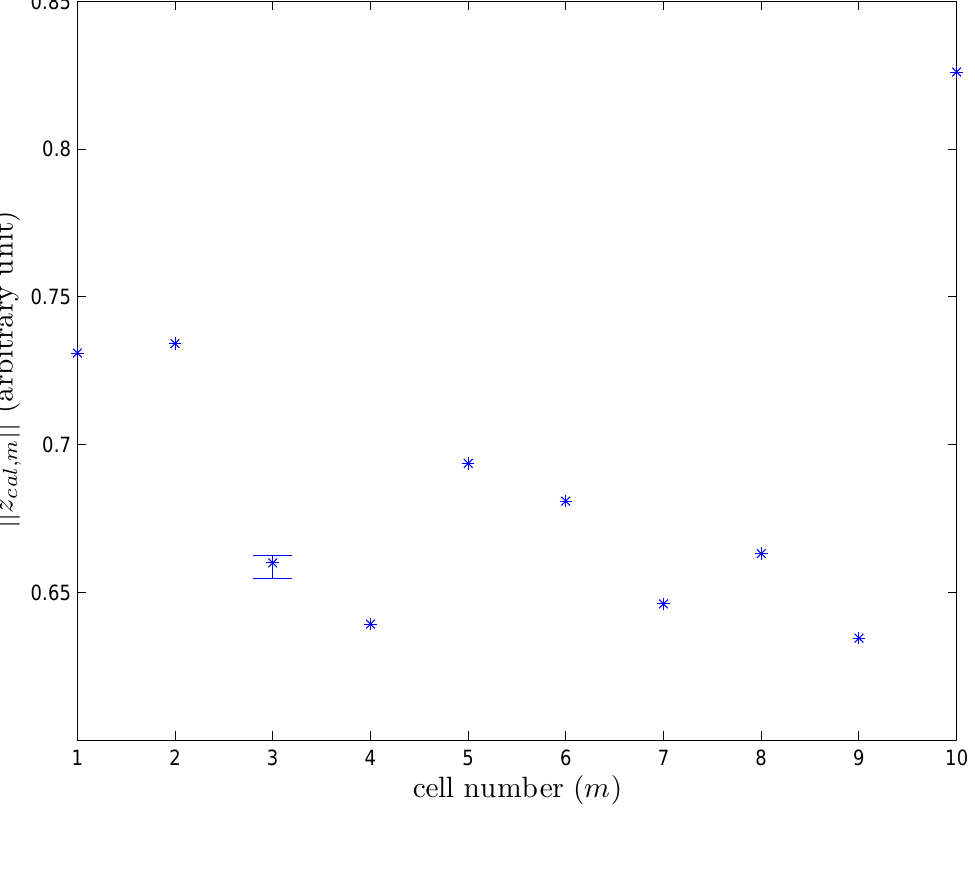
∥ plot for 1 (cid:20) m (cid:20) 10 with time-dependent variation of ∥ z Figure 10. ∥ z sig;m